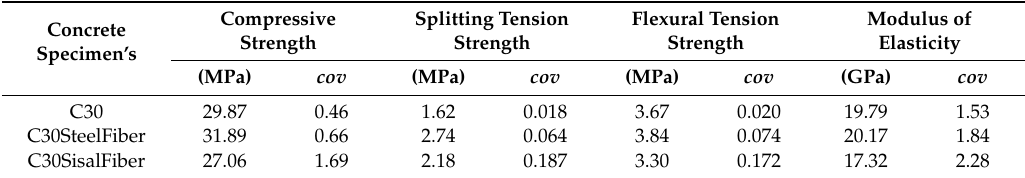
( b ) Figure 16. Space trusses tested: ( a ) Dimensions and ( b ) plan view of the prototypes.